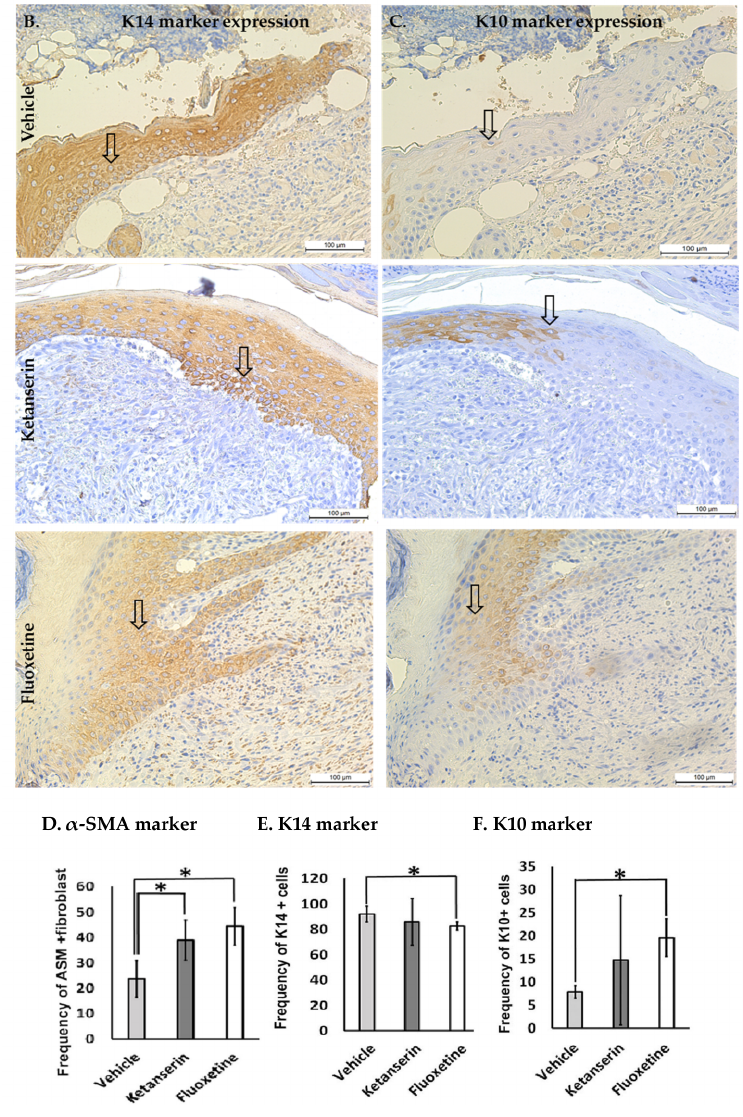
Figure 4. Comparative expression of dermal myofibroblasts alpha smooth muscle actin ( α -SMA), epidermal K14 and K10 markers during skin wound healing in vehicle, ketanserin and fluoxetine treatment groups. Two weeks post thermal skin wound sections were harvested and immunostained for these markers. ( A ) Expression of α -SMA in wound dermal fibroblasts (arrow indicate α -SMA + ve cells); ( B ) Expression of K14 and ( C ) K10 in newly formed epidermal layers over the wound area (arrow indicate K14 and K10 + ve keratinocytes in separate images). Image scale bar: 100 µ m. Graphical results show comparative ( D ) α -SMA ( E ) K14 and ( F ) K10 expression among treatments after two weeks’ post thermal injury. Results were presented as mean ± Standard Deviation (SD), (* p < 0.05), n =